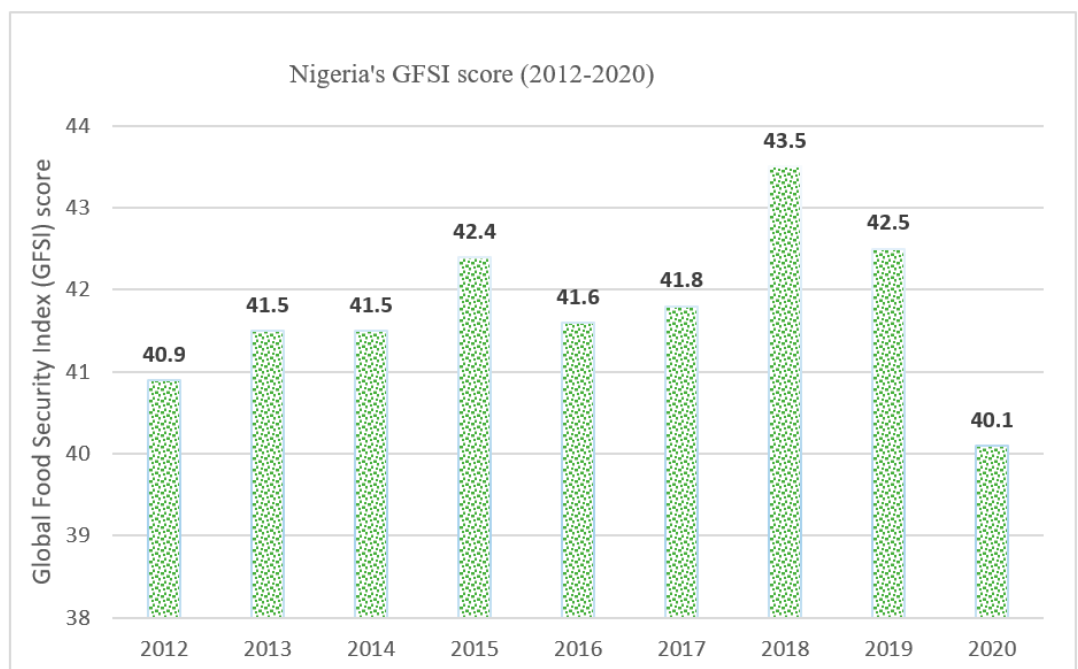
Figure 1. Nigeria’s Global Food Security Index (2012–2020). Source: authors’ graph using underlying GFSI 2012–2020 (Nigeria exported) [17].